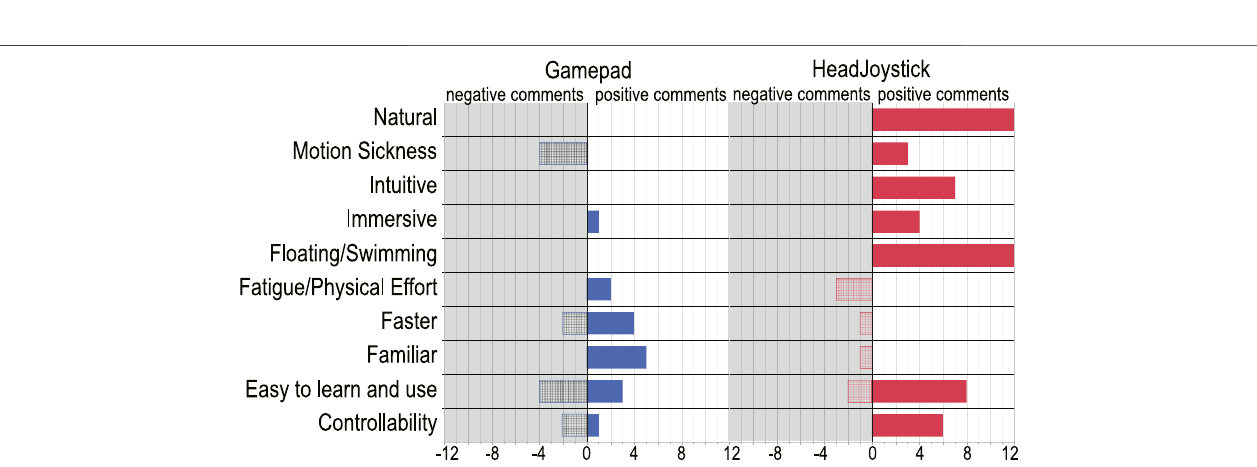
FIGURE 9| User rating regarding statements about usability and preference,motion sickness, immersion, comfort, and long-term use. Green and lighter shade of green respectively indicate signi fi cant ( p ≤ 5 % ) and marginally signi fi cant ( p ≤ 10 % ) differences in favor of HeadJoystick. Lighter shade of red indicates marginally higher ratings in favor of Gamepad ( p ≤ 10 % ). Note: * denotes statements with undesirable quality (reversed scale). Effectively, the green highlights in those statements with * indicate that HeadJoystick had lower task dif fi culty and made participants less motion sick. A (cid:2) Gamepad interface, × (cid:2) HeadJoystick interface, CI (cid:2) 95 % .